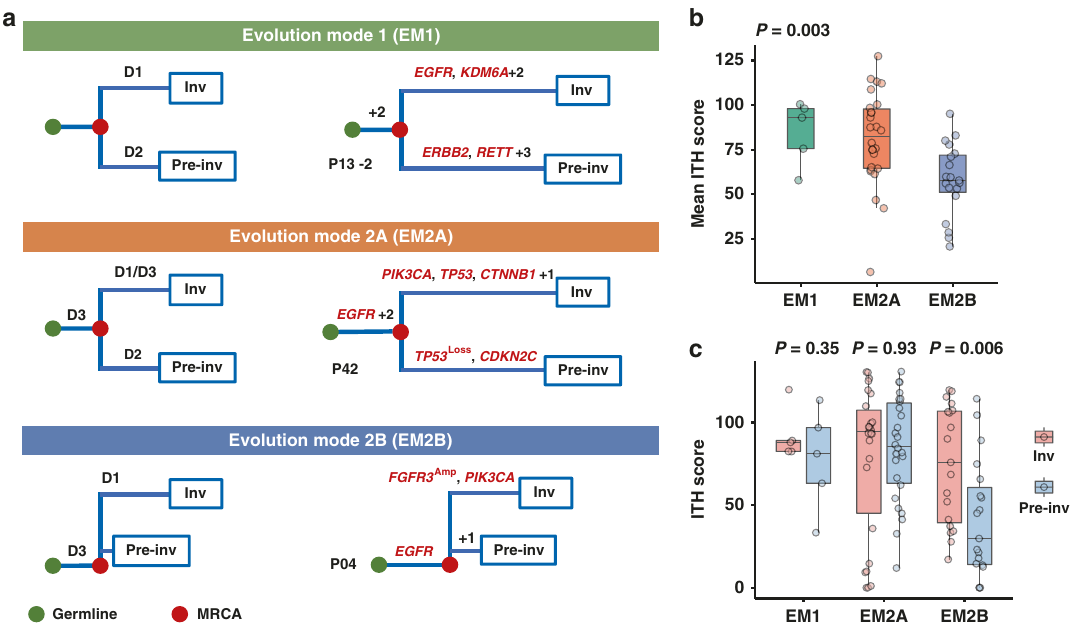
Fig. 2 Phylogenetic analyses within MPNs. a Evolutionary trajectories of pre-invasive and adjacent invasive MPN components. For each of the three evolutionary patterns, D1, D2, and D3 indicate three hypothetical key molecular events in trunk and branches of phylogenetic tree; green dots represent the germline and red dots represent the most recent common ancestor (MRCA) for each pair of components. In evolution mode 1 (EM1), none of driver mutations are shared and D1 and D2 indicate different private driver alterations (Supplementary Fig. 4a), and JSCH P13-2 is a representative MPN. In evolution mode 2 (EM2), MRCA harbors critical common events (D3). Private driver alterations of D2 and D1 are restricted to the pre-invasive component (EM2A; Supplementary Fig. 4b) and the invasive component (EM2B; Supplementary Fig. 4c), respectively. Phylogenetic trees of JSCH P42 and P04 are shown to represent EM2A and EM2B separately. b Mean intratumor heterogeneity (ITH) score of 50 paired pre-invasive and adjacent invasive components suggests phenotypic differences including EM1 (MPNs, n = 5), EM2A (MPNs, n = 26), and EM2B (MPNs, n = 19). The differences were assessed using Kruskal – Wallis H test. c Comparisons of ITH levels between 50 paired pre-invasive and invasive components were performed using two- sided Wilcoxon Rank-Sum test. The box plot displays the fi rst and third quartiles (top and bottom of the boxes), median (band inside the boxes), and lowest and highest point within 1.5 times the interquartile range of the lower and higher quartile (whiskers). Inv, Invasive and Pre-Inv,